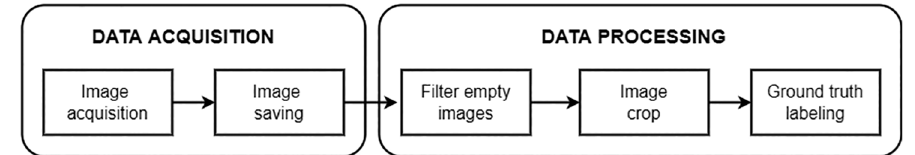
Figure 1. Research stages, including data acquisition and data processing